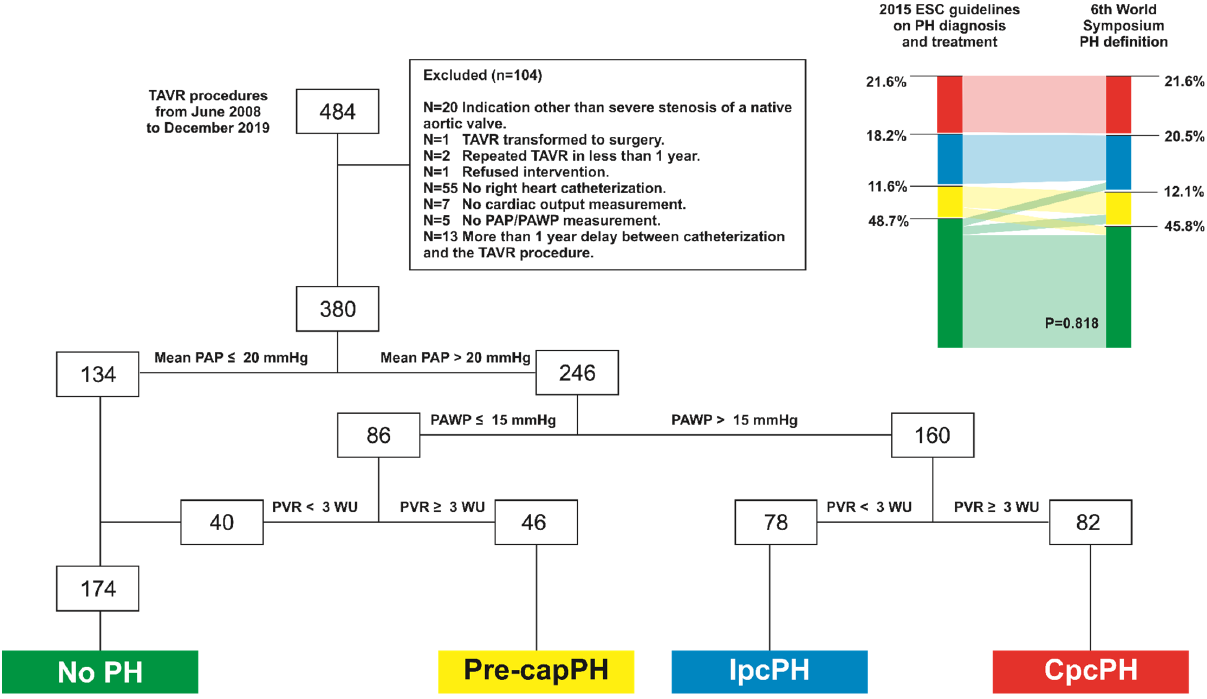
Figure 1. Study flow chart, and PH groups of the study population, according to the novel defini ‐ tion. Reclassification effect of PH groups as compared to the criteria proposed in the 2015 ESC guide ‐ lines on PH diagnosis and treatment. TAVR: Transcatheter aortic valve replacement; PA: Pulmonary artery pressure; PAWP: pulmonary arterial wedge pressure; PVR: pulmonary vascular resistance; WU: Wood Units; PH: pulmonary hypertension; Pre ‐ cap: Pre ‐ capillary; Ipc: Isolated post ‐ capillary;